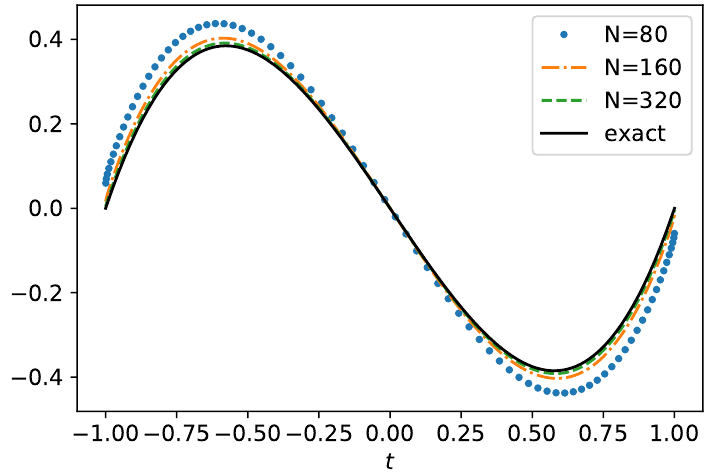
Figure 1. Numerical solutions of the Equation (54). The solid line stands for the exact solution x ∗ ( t )